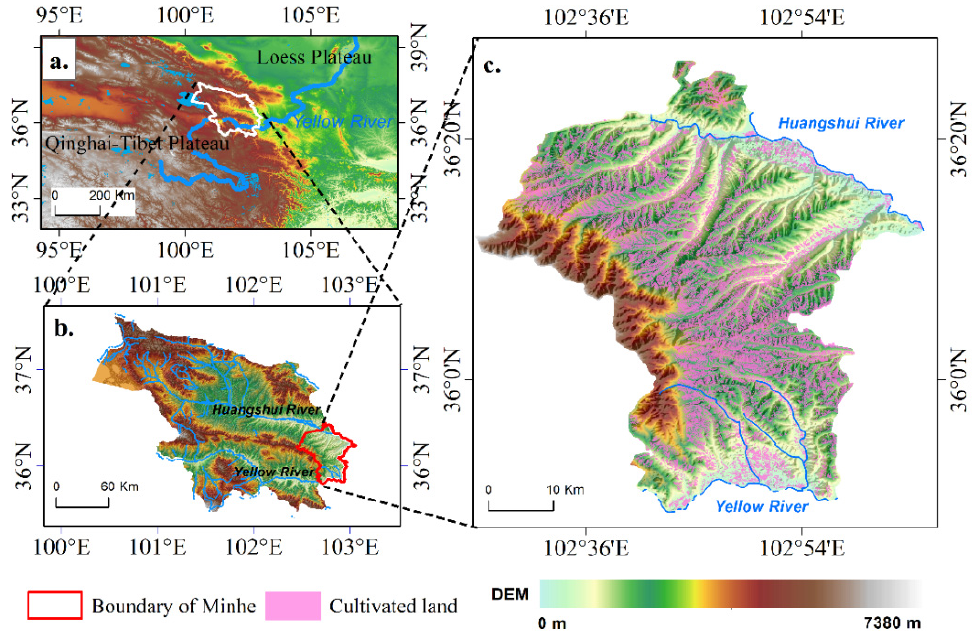
Figure 1. Study area locations of the Qinghai–Tibet Plateau and Minhe. ( a ). Location of Hehuang Valley; ( b ). Location of Minhe in Hehuang Valley; ( c ). DEM and Cultivated land distribution of Minhe (DEM: digital elevation